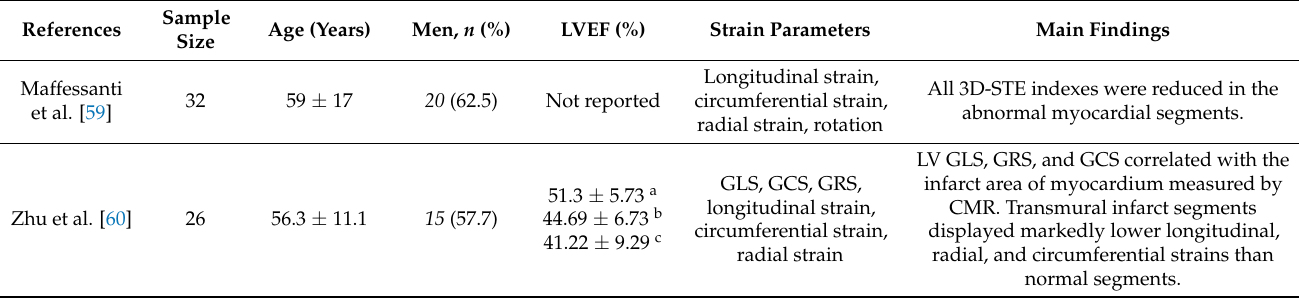
Table 2. Assessment of LV regional systolic function in HF patients using